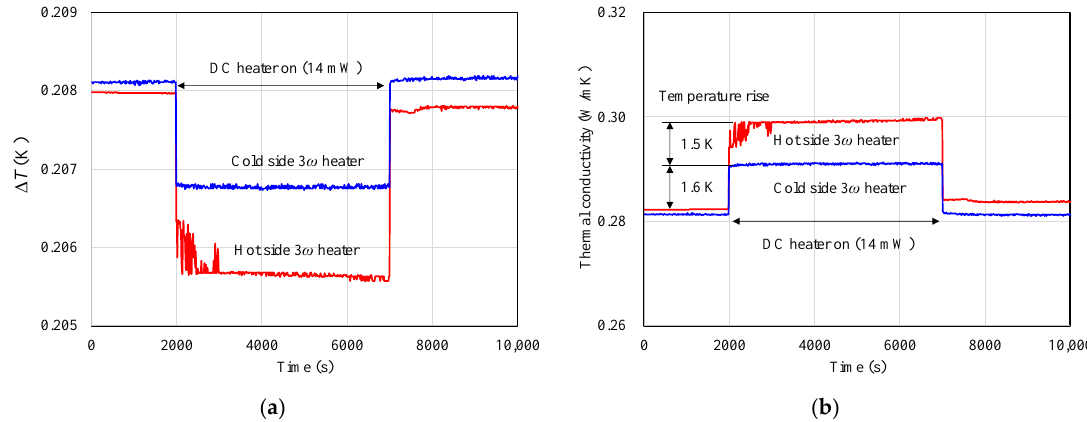
Figure 7. Transient ( a ) temperature amplitudes and ( b ) thermal conductivities of the nanofluid measured at the hot 3 ω heater (red line) and cold 3 ω heater (blue line) with the DC heater turned on from 2000 to 7000 s.